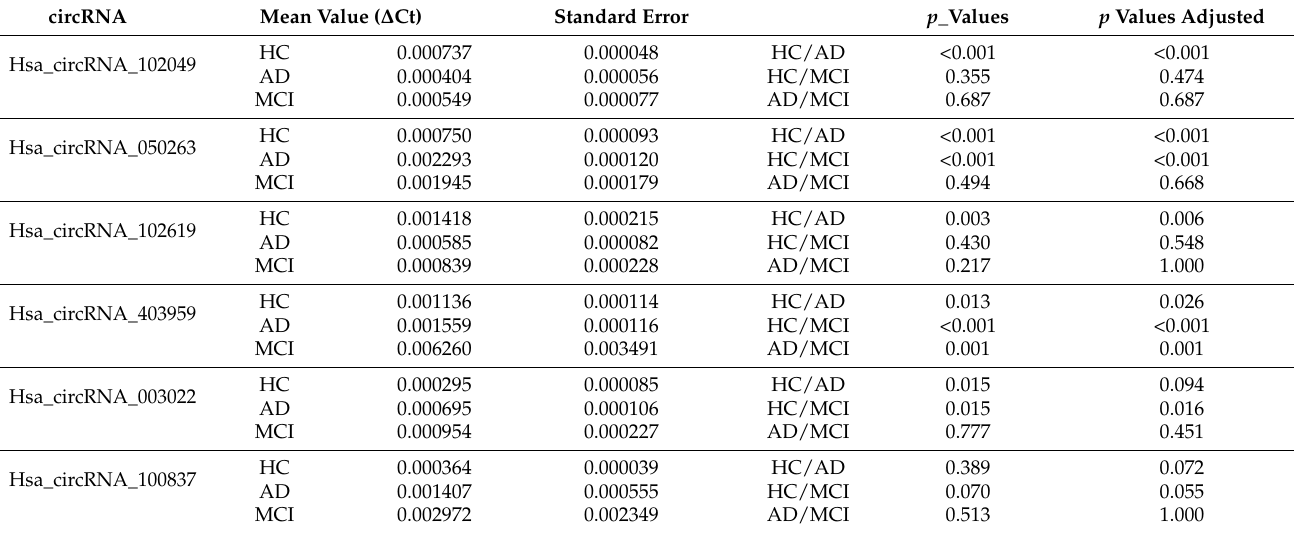
Table 3. Mean ∆ Ct values and the respective standard errors of each circRNA, for HCs, AD, and MCI participants. In the last columns, p -values and p -values adjusted for sex and age-related to each comparison are reported.